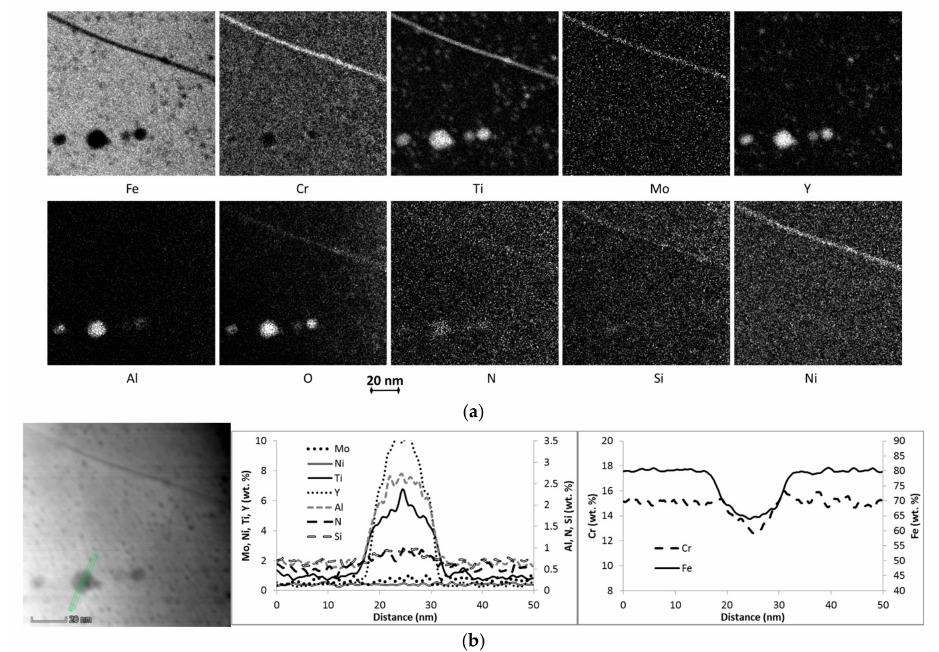
Figure 5. STEM-EDX maps and profile of chemical composition of coarser precipitate in the He720 condition: ( a ) The maps show the composition of the particles and enrichment with Cr, Ti, Mo, O, N, Si, and Ni at the grain boundary; ( b ) The line shows enrichment with Y, Al, and Ti in the coarser